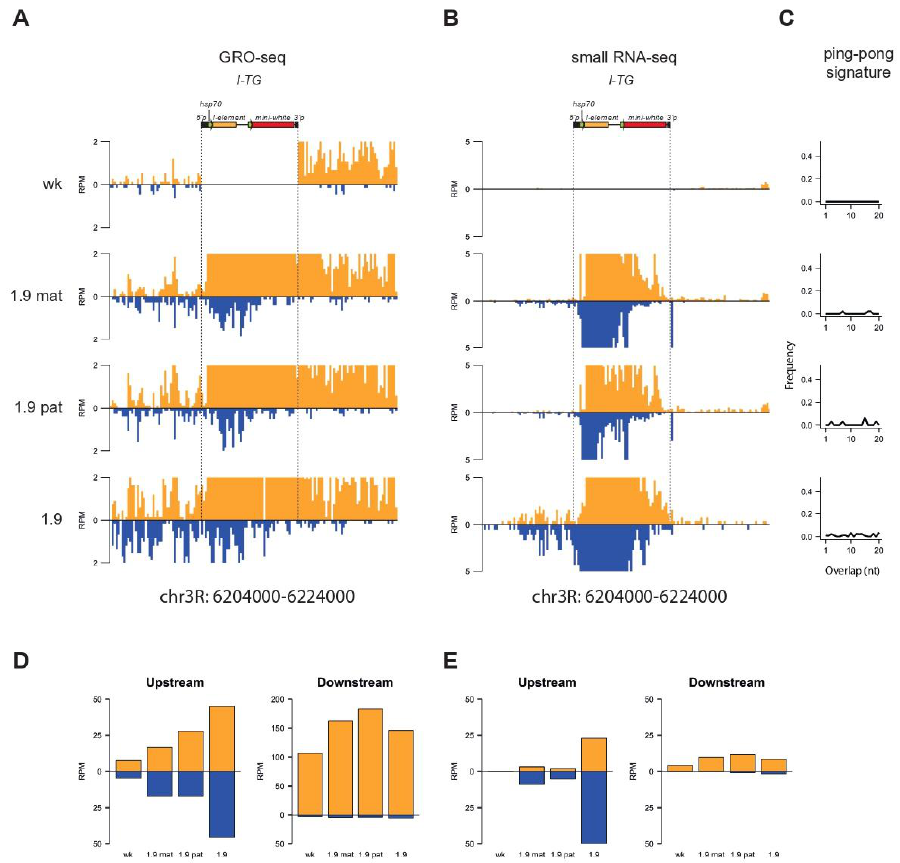
Figure 6. Analysis of Global Run-On sequencing (GRO-seq) performed on ovaries of R strains after maternal or paternal inheritance of the 1.9 I-TG transgene. ( A ) Normalized GRO-seq reads mapping to the 1.9 w transgene insertion region ( ± 10 kb) in 1.9 w mat, 1.9 w pat, 1.9 w , and 3.1 (designated as w K ) strains (brown—sense; blue—antisense, no mismatches allowed). The 3.1 strain contained the I-TG transgene in subtelomeric region and was used here as a control for the 1.9 w transgenic strain. Genome coordinates are given according to the Drosophila R5 release. ( B ) Small RNA-seq reads (19–29 nt, brown—sense; blue—antisense) mapping at the same region and in the same strains as in ( A ). ( C ) Ping-pong signature: Relative frequencies of 5′-overlap length (one to 20 nucleotides) between sense and antisense 24–29-nt small RNAs mapping to the upstream region (10 kb) of the 1.9 w transgene insertion sites in the same strains as in ( A ). ( D ) Normalized counts of GRO-seq reads mapping to the upstream and downstream regions of the 1.9 w transgene insertion site (± 10 kb). ( E ) Counts of small RNA-seq reads (19–29 nt) mapping to the upstream and downstream regions of the 1.9 w transgene insertion site (± 10 kb).